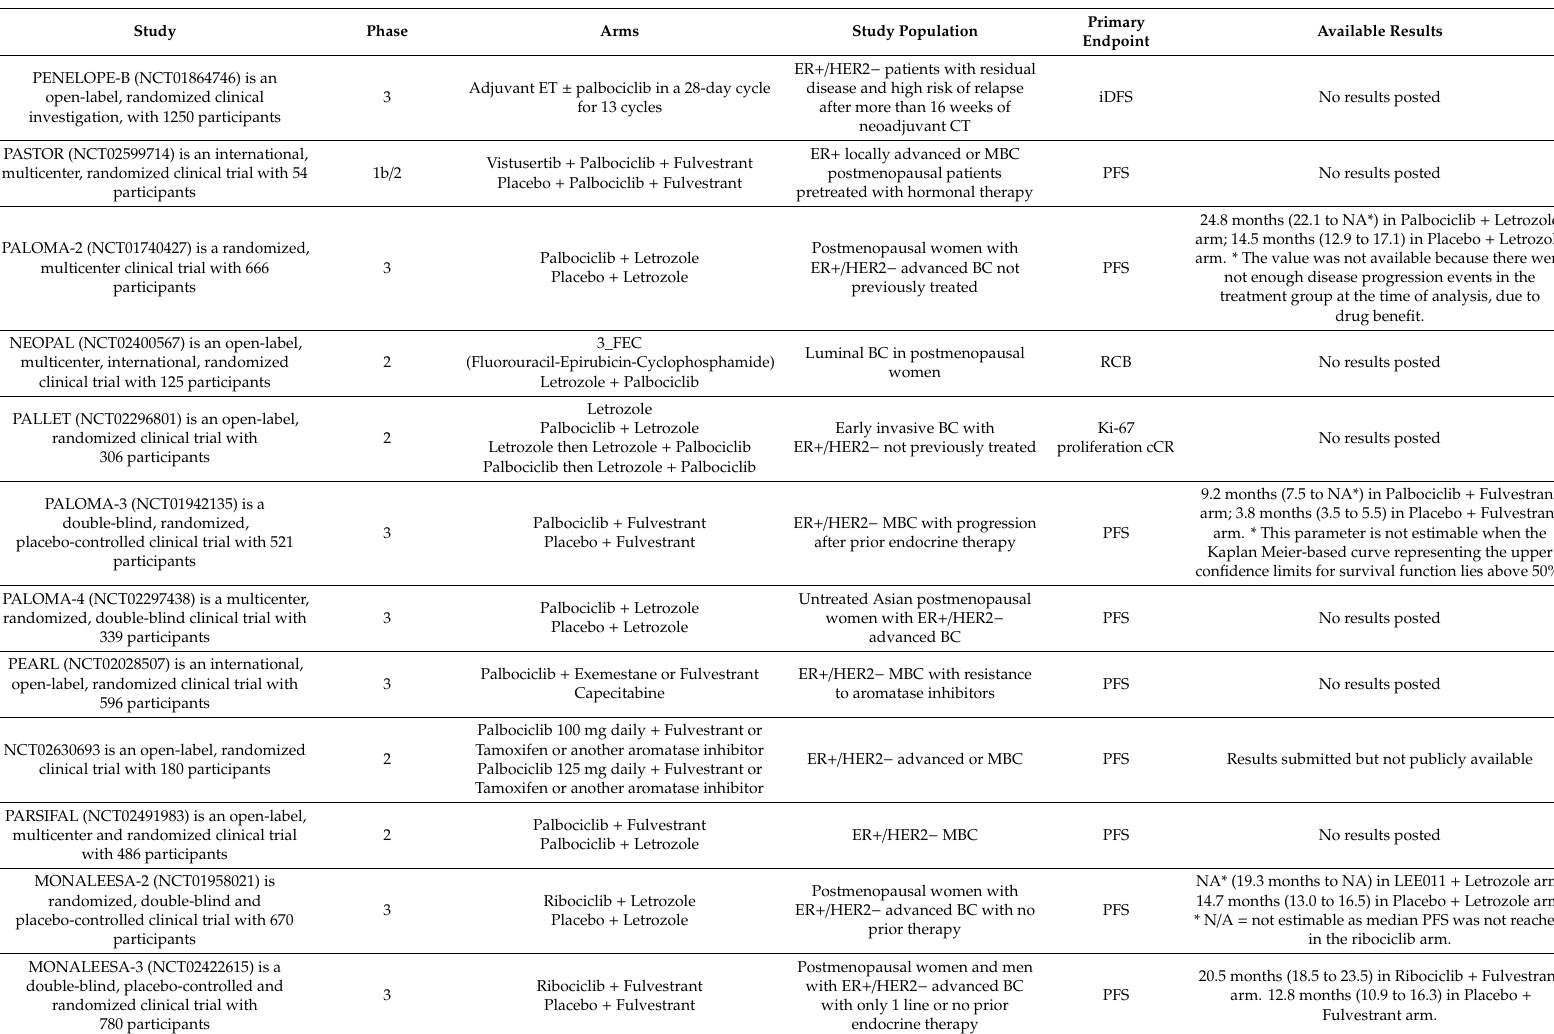
Table 2. Ongoing randomized phase II / III clinical trials investigating CDK4 / 6 inhibitors in breast